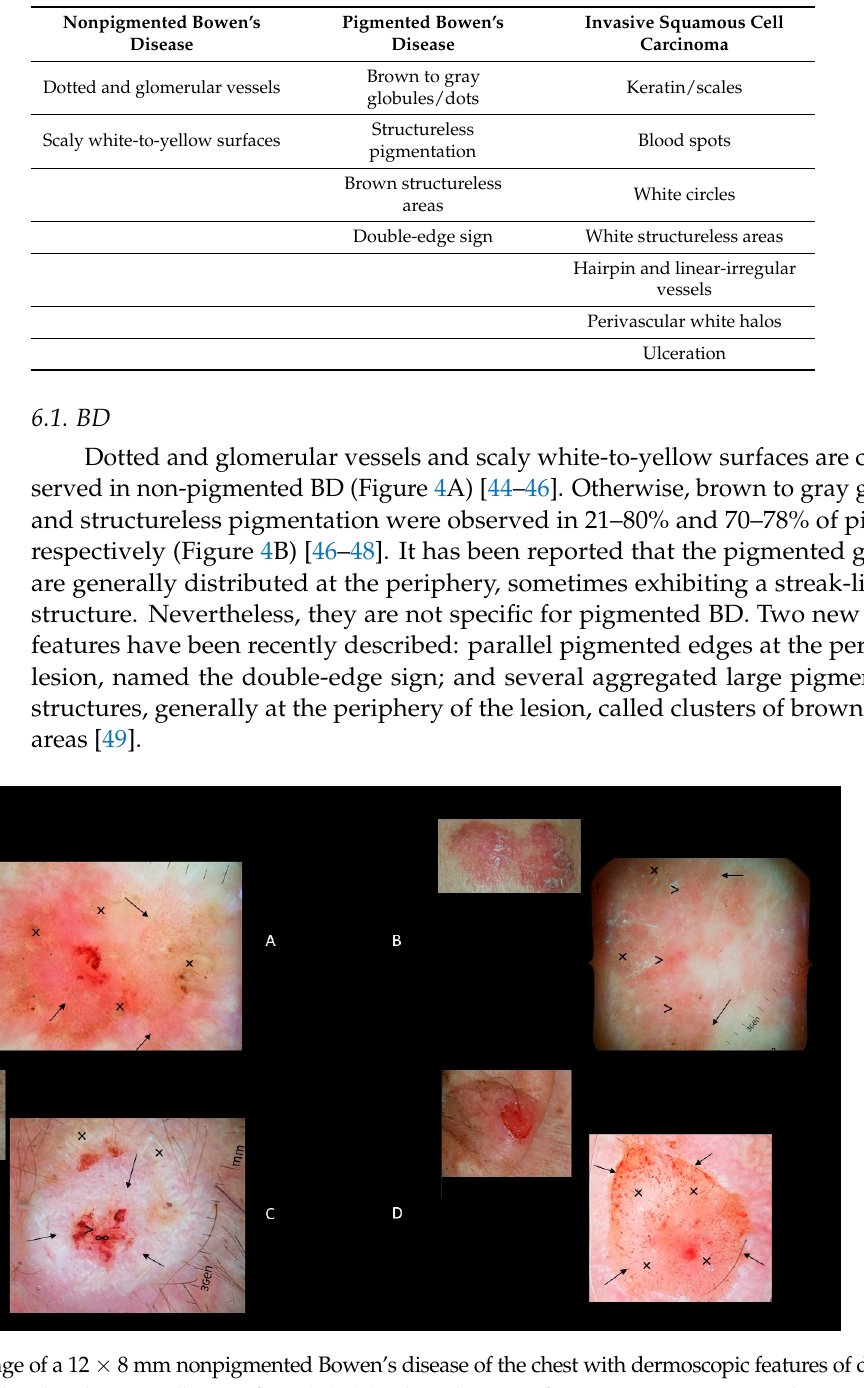
Table 2. Dermoscopic structures of cutaneous squamous cell carcinoma (cSCC) [44].